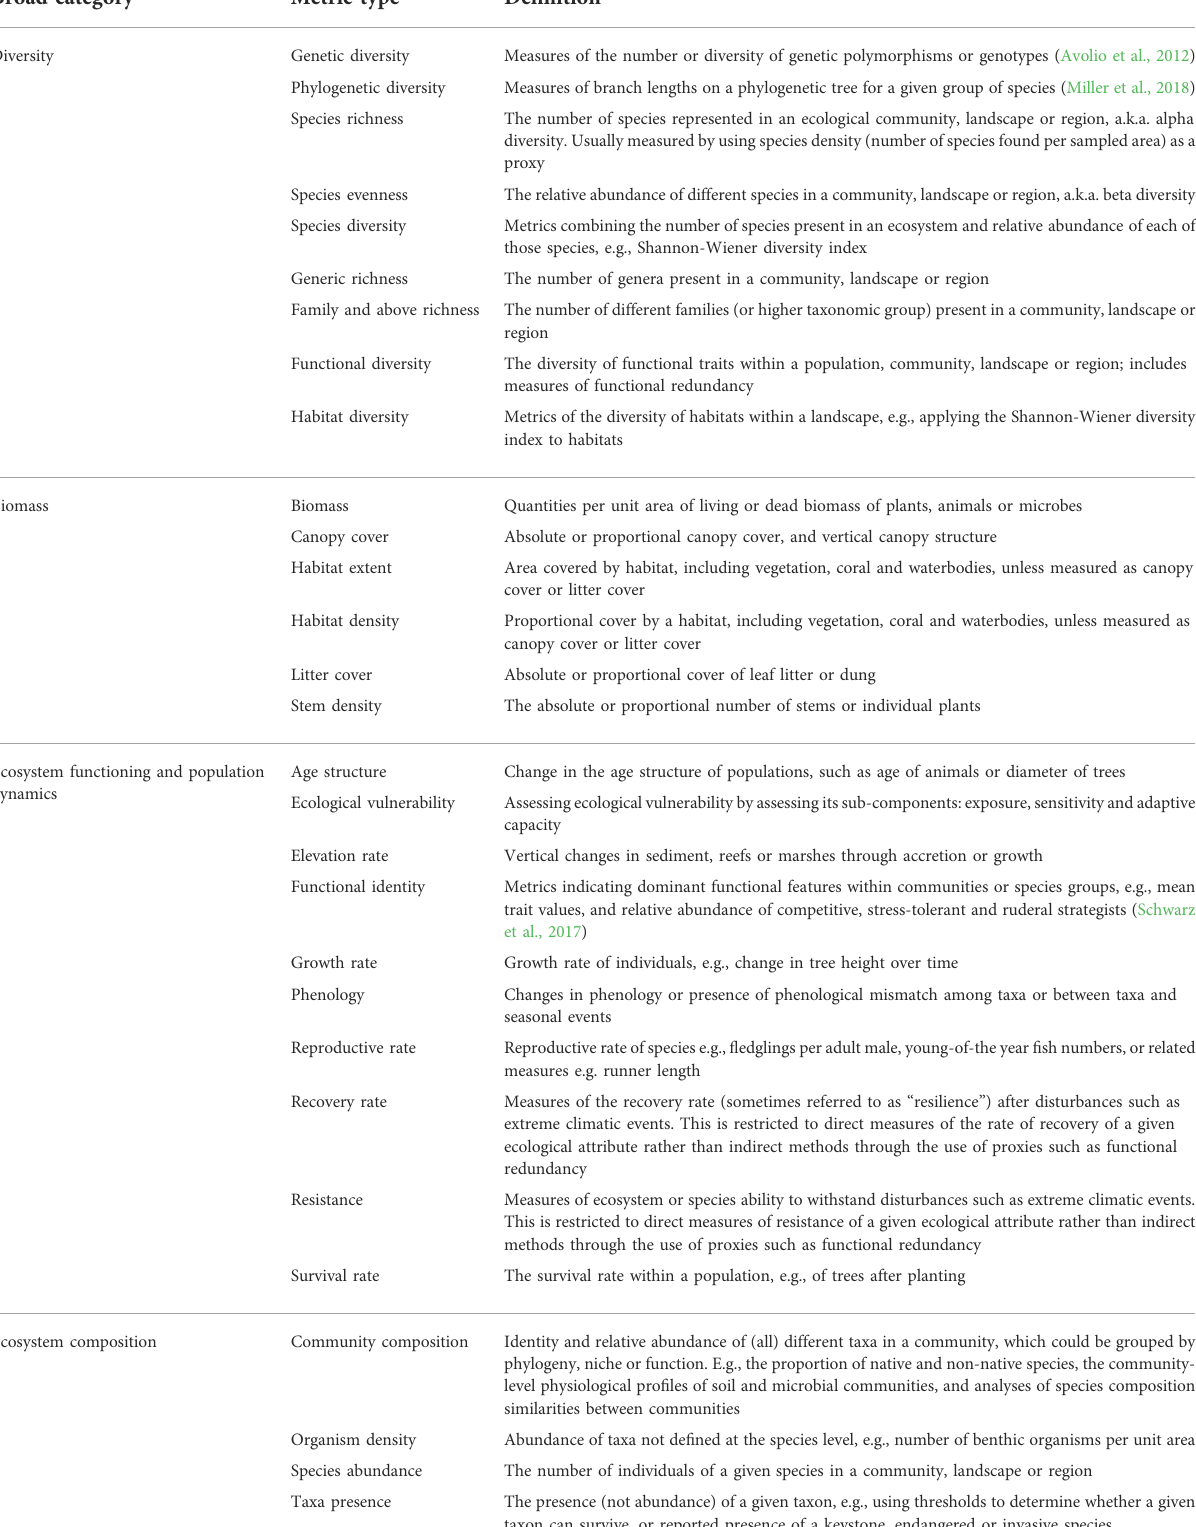
TABLE 2 Ecosystem health broad metric categories, metric types and de fi nitions used to code the ecosystem health outcomes of